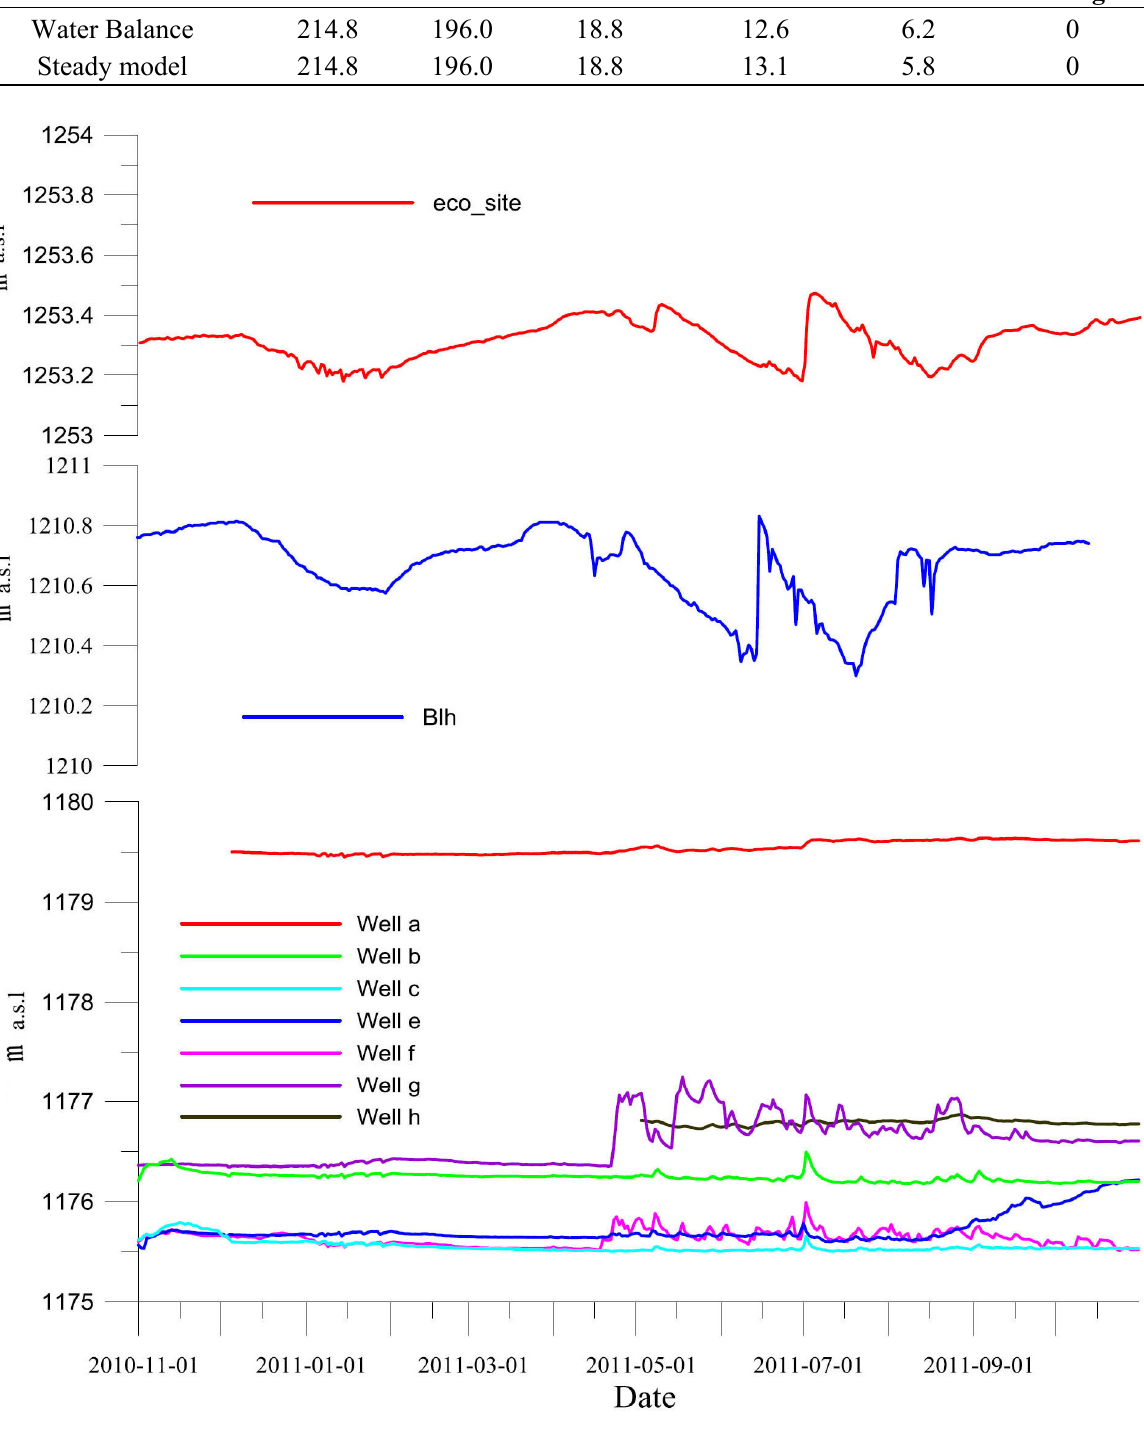
Figure 6. Observed groundwater levels in Bulang